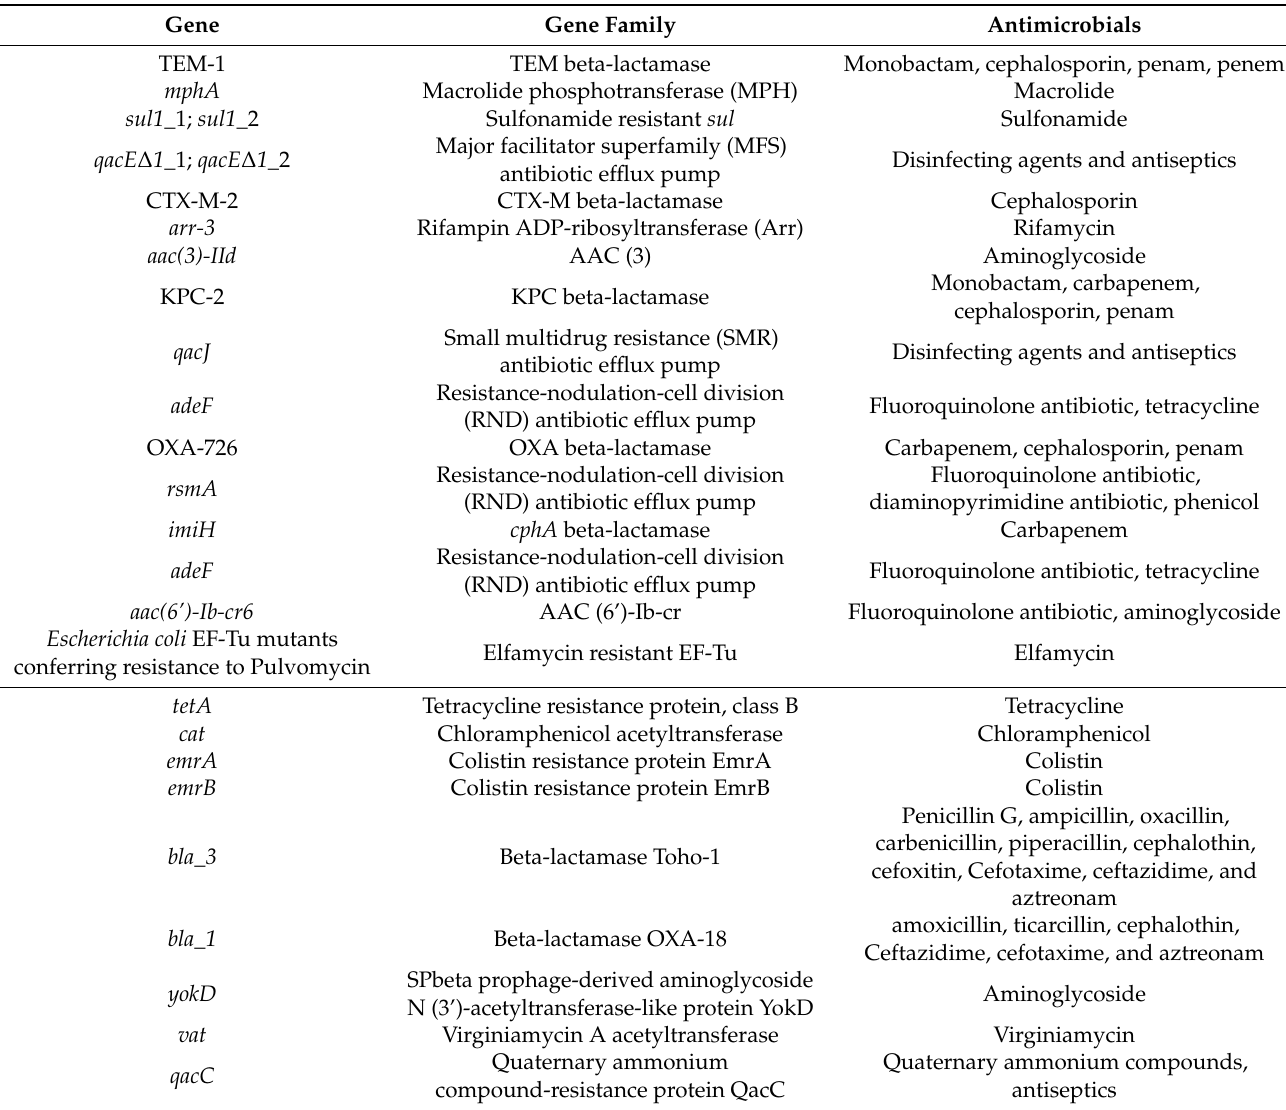
Table 1. Antimicrobial resistance genes detected in the A. hydrophila 34SFC-3 genome, their correspond- ing gene family, and antimicrobials to which they confer resistance. The first part of the table refers to the results obtained in the CARD database, and the second, to the results obtained by manual curation. Gene